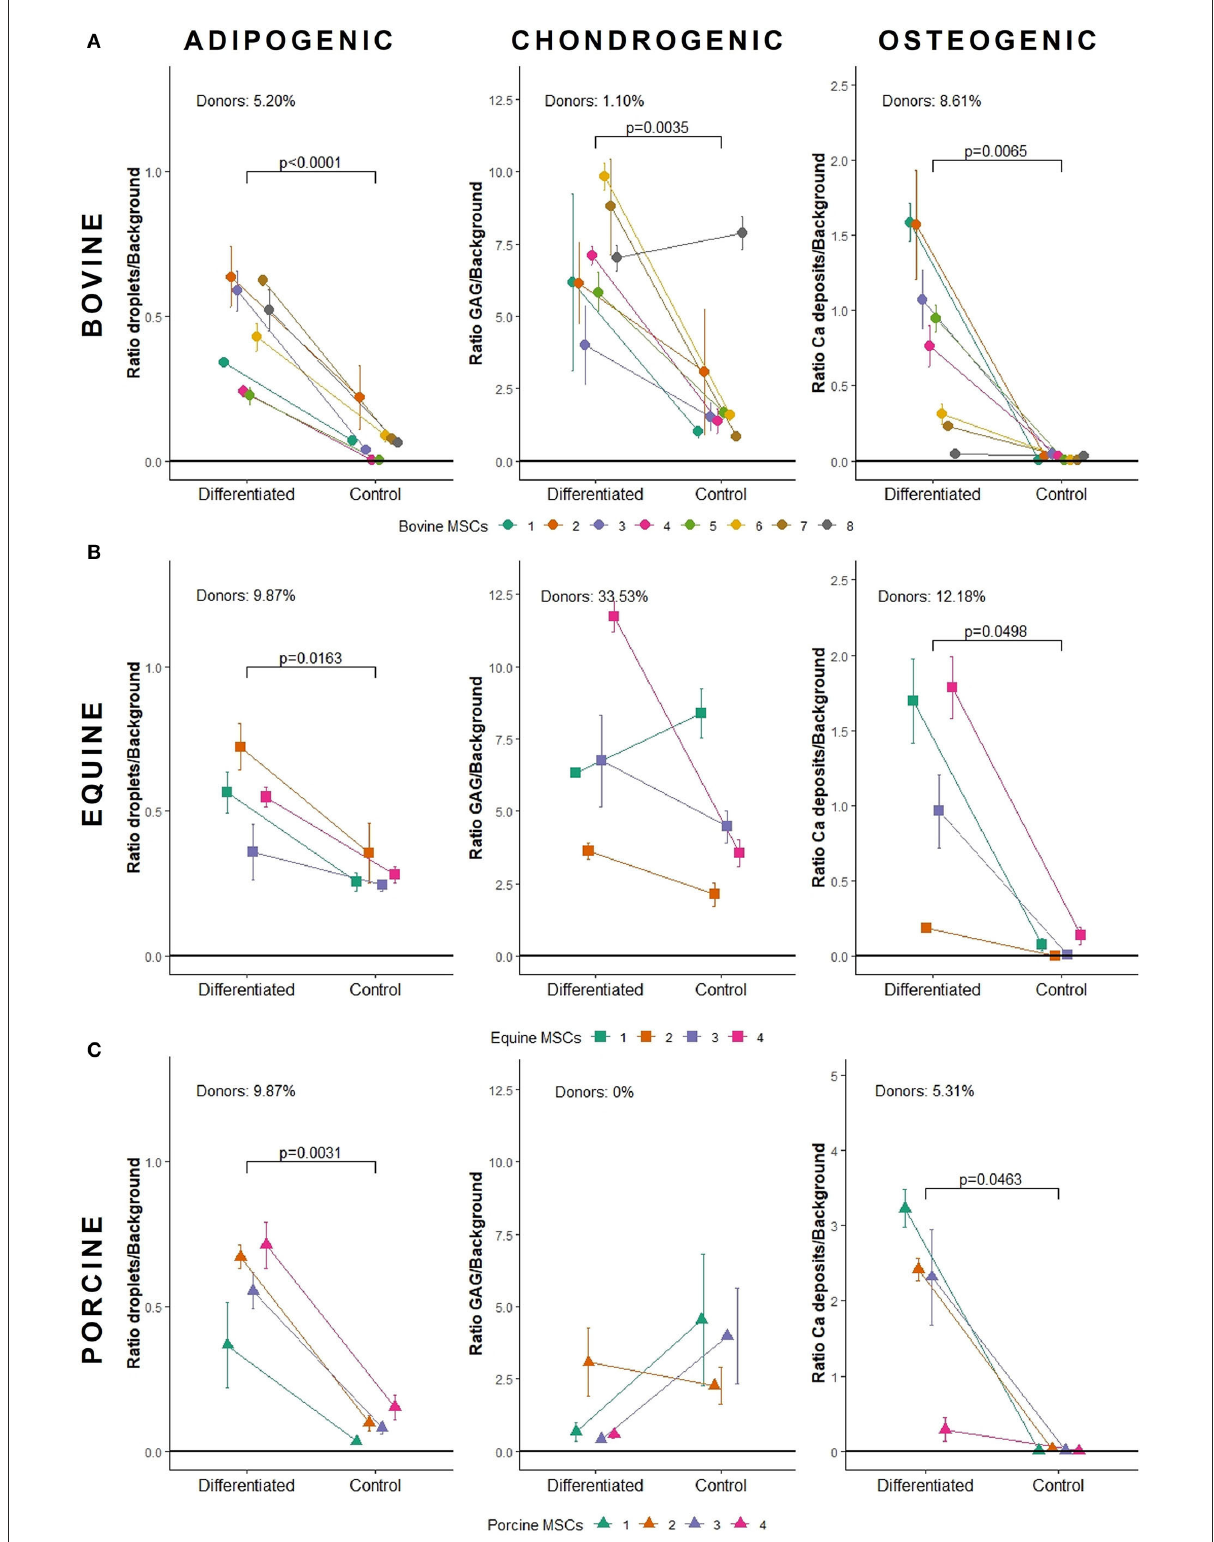
FIGURE3 Quantification of tri-lineage differentiation potential of (A) bovine MSCs ( n = 8), (B) equine MSCs ( n = 4), and (C) porcine MSCs ( n = 4). Donors are linked in an interaction plot and the mean differentiation ratio with standard deviation is shown per lineage. GAG, glycosaminoglycans.